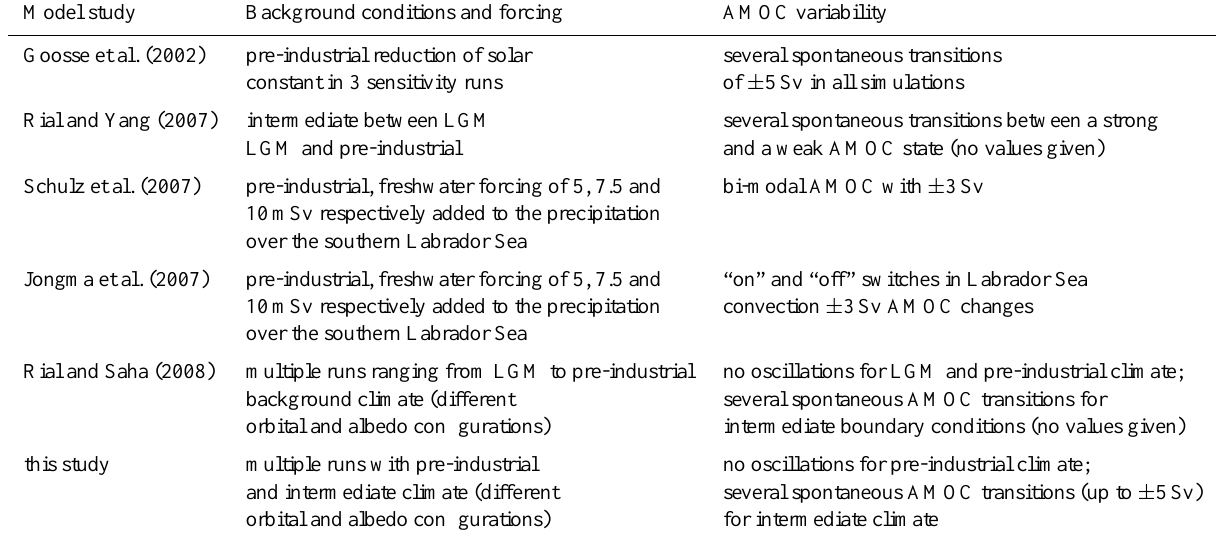
Table 1. Summary of modelling studies that observed low-frequency AMOC oscillations in the ECBilt-CLIO climate model. Model study Background conditions and forcing AMOC variability Goosse et al. (2002) pre-industrial reduction of solar several spontaneous transitions constant in 3 sensitivity runs of ± 5Sv in all simulations several spontaneous transitions between a strong and a weak AMOC state (no values